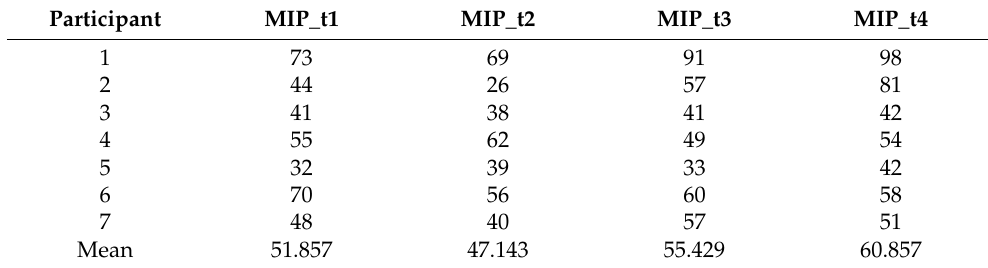
Table 4. MIP (cm H 2 O) individual and mean measurements at four assessment time points.